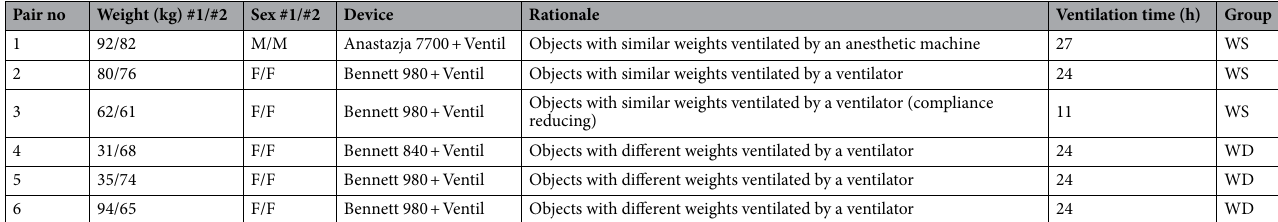
Table 1. Animal experiment configuration. Ventilation of different animal pairs by the Ventil together with the anesthetic machine or the ventilator. # 1, The first ventilated subject; #2, The second ventilated subject; WS, Similar weight group; WD, Different weight